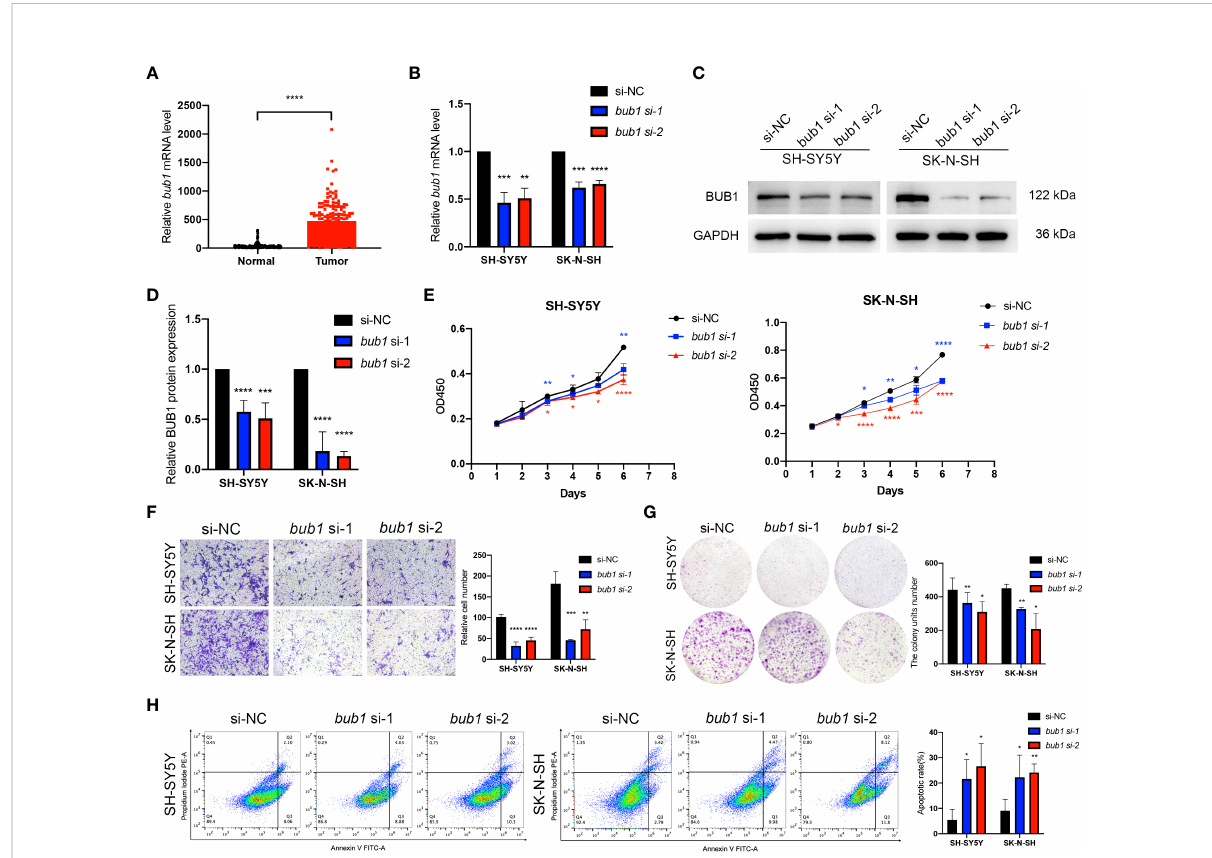
FIGURE 3 Expression of bub1 promotes proliferation and migration of neuroblastoma cancer cells in vitro . Expression of bub1 in the TARGET dataset (A) . RT-qPCR (B) , qualitative (C) , and quantitative (D) western blot analysis all suggested that siRNA successfully degraded bub1 mRNA and prevented Bub1 protein synthesis in two cancer cell lines. NC, negative control. (E) CCK8 cell proliferation experiment after interfering bub1 expression using siRNA in SH-SY5Y and SK-N-SH cells. (F) Qualitative analysis of cell migration after interfering bub1 expression using siRNA in SH-SY5Y and SK-N-SH cells. Cells were stained with 0.1% crystal violet solution and examined with a light microscope. Magni fi cation = 40 x. (G) Quantitative analysis of cell proliferation using colony formation assay showed signi fi cantly fewer colonies formed by bub1 -silenced SH- SY5Y and SK-N-SH cells relative to their untreated controls. (H) Flow cytometry showed that bub1 silencing increased early apoptosis of SH- SY5Y, and early and late apoptosis of SK-N-SH cells. Early and late apoptotic cells were characterized respectively as PI-/Annexin V+ and PI +/Annexin V+. All experiments were carried out in three biological repeats. Data are presented as the mean ± standard deviation (SD). * p < 0.05, ** p < 0.01, *** p < 0.001, **** p <